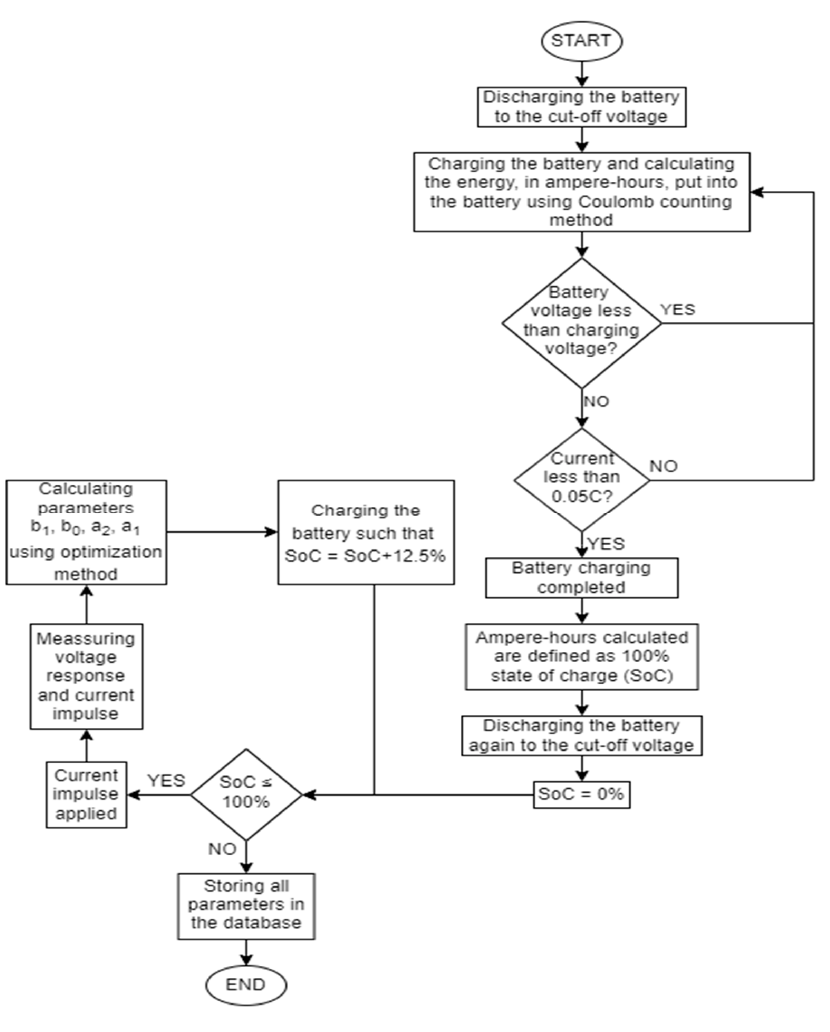
Figure 2. Flowchart of the learning process.